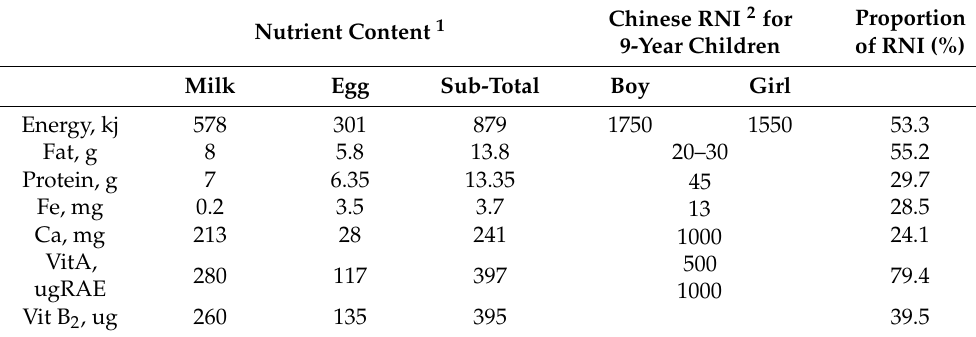
Figure 1. Flow diagram of participation. Table 1. Comparison of nutrient content of milk and egg with Chinese RNI for nine year old children in the supplementation trial.